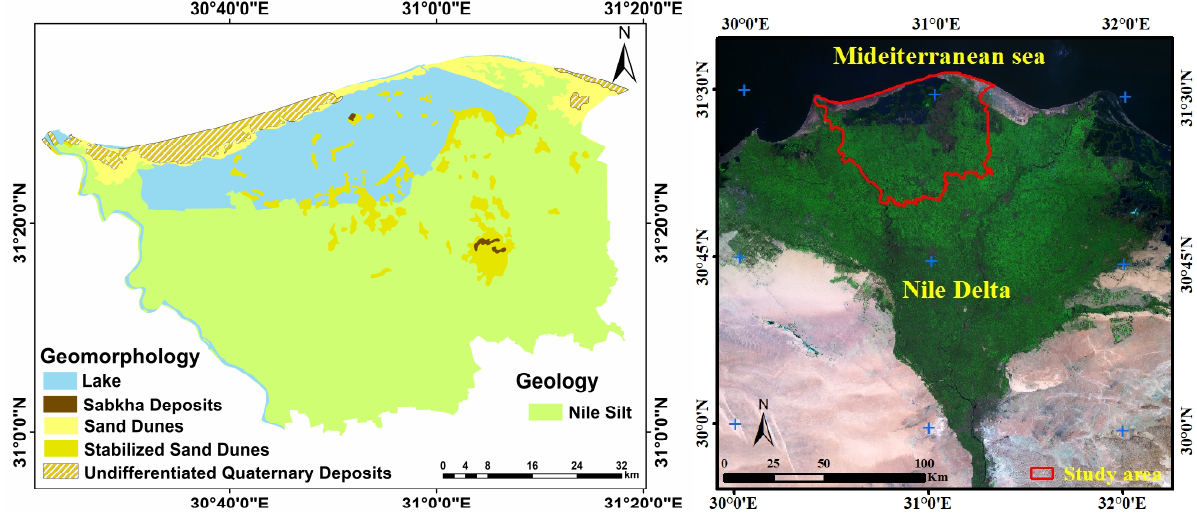
Figure 1. Geomorphology associated with geology (after [27] Conoco (1987)). Location map of the study area.